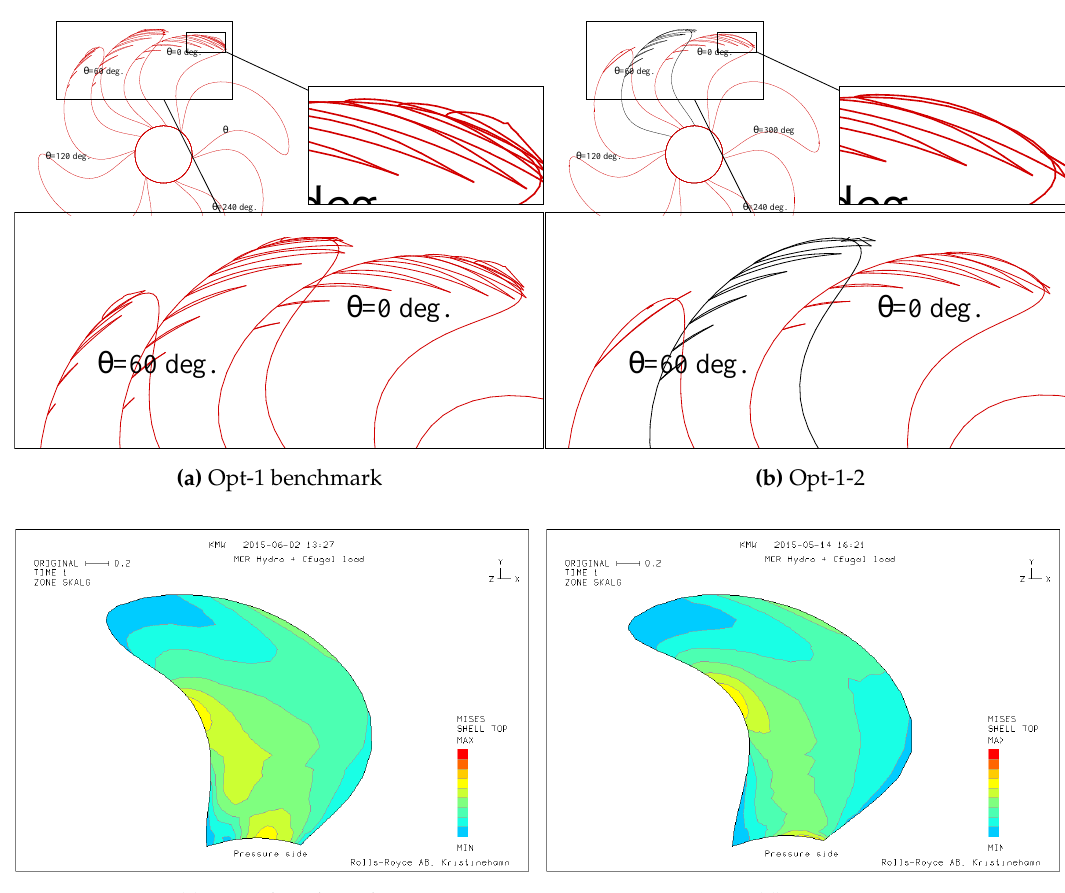
Figure 6. Cavitation performance of a finite element method (FEM) simulation of hydrodynamic and centrifugal loads of benchmark propeller case Opt-1 and optimised design Opt-1-2. ( a ) Opt-1 benchmark; ( b ) Opt-1-2; ( c ) Opt-1 benchmark; ( d )